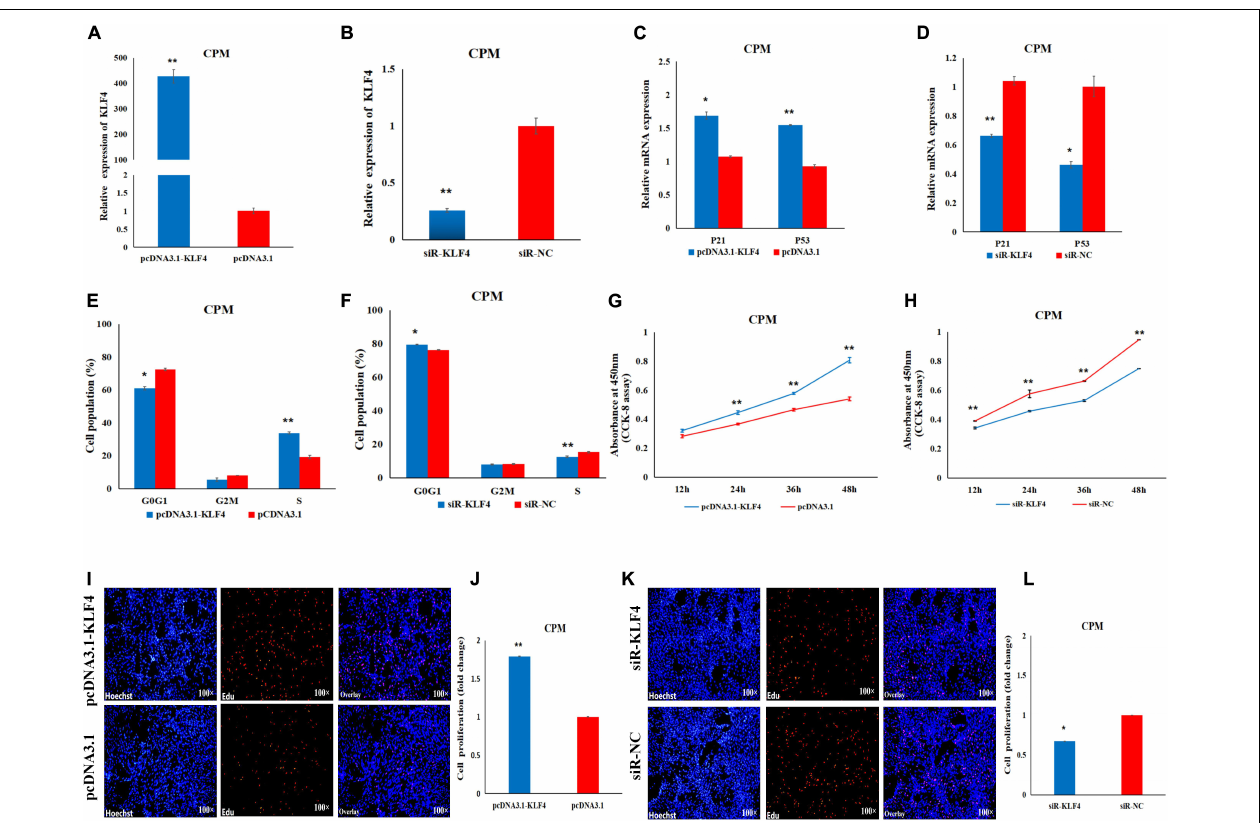
FIGURE 5 | KLF4 promotes the proliferation of CPMs. (A) The expression level of KLF4 after its 48 h overexpression in CPMs. (B) The expression level of the KLF4 gene after its 48 h inhibition in CPMs. (C,D) The P21 and P53 mRNA expression levels 48 h after the overexpression and inhibition of the KLF4 gene in CPMs. (E,F) Cell cycle analysis after KLF4 gene overexpression and inhibition in CPMs. (G,H) Proliferation curve within 48 h after the overexpression and inhibition of the KLF4 gene in CPMs. (I,K) EdU proliferation assays for CPMs after overexpression and inhibition of the KLF4 gene. (J,L) The fold change of the proliferation rates after overexpression and inhibition of the KLF4 gene. Photomicrographs were taken using a 100 × magnification. The results are shown as the mean ± SEM of three independent experiments, * p < 0.05, ** p <